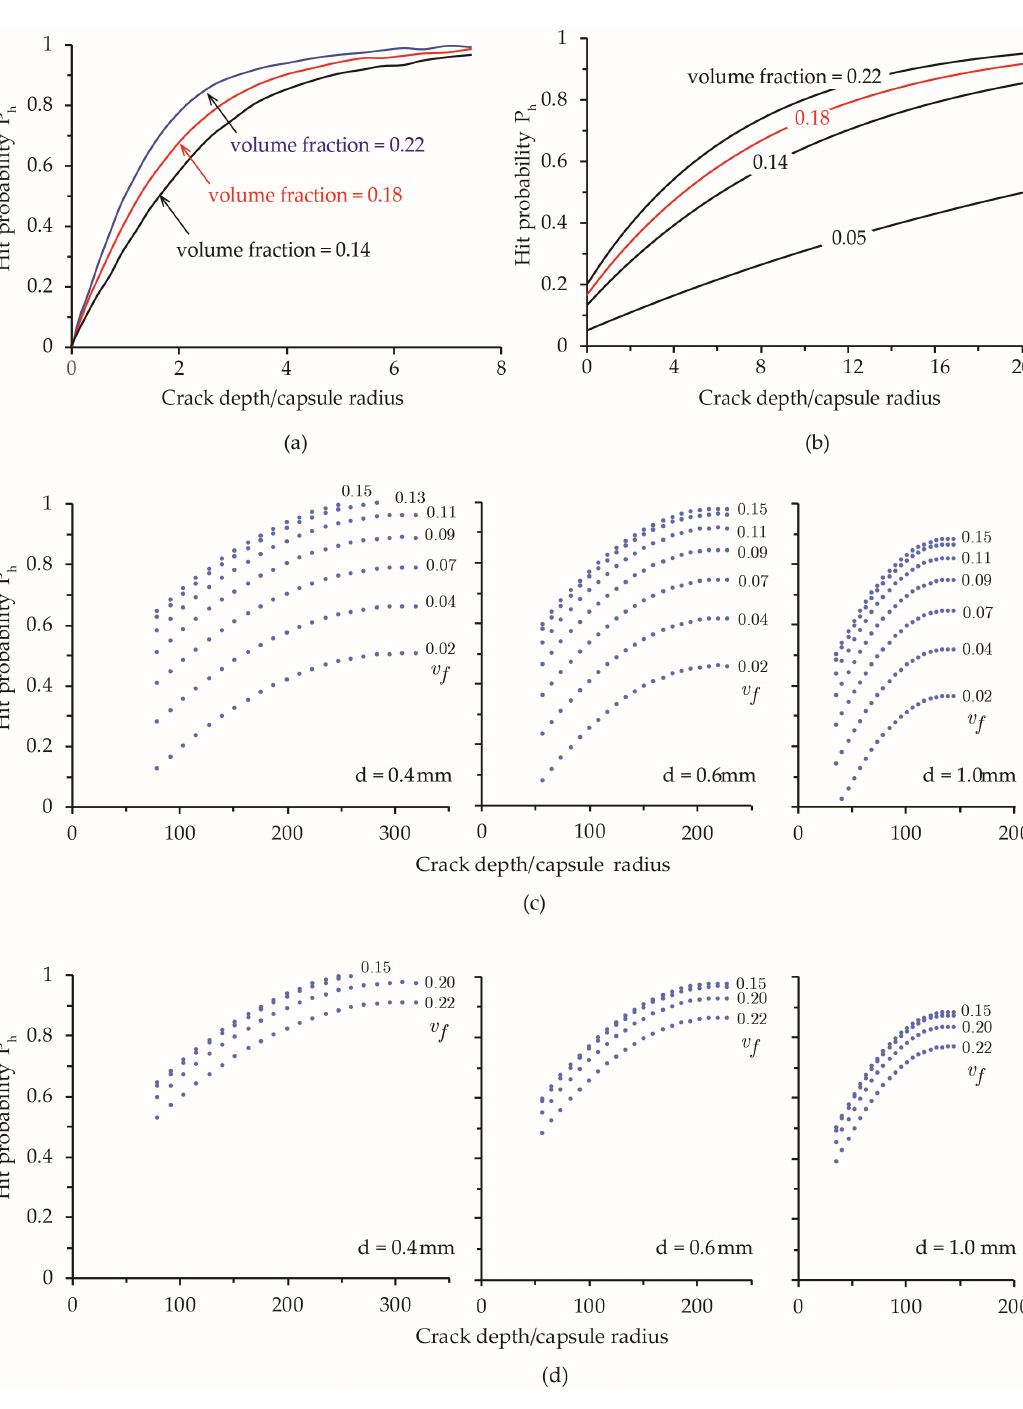
Figure 15. Simulations results by ( a ) Zemskov et al. [19] and ( b ) Lv and Chen [17]; ( c , d ) Variation of hit probability predicted by regression model with normalized crack depth, for different capsule volume fractions υ f = 0.02 − 0.15 and υ f = 0.15 − 0.22,